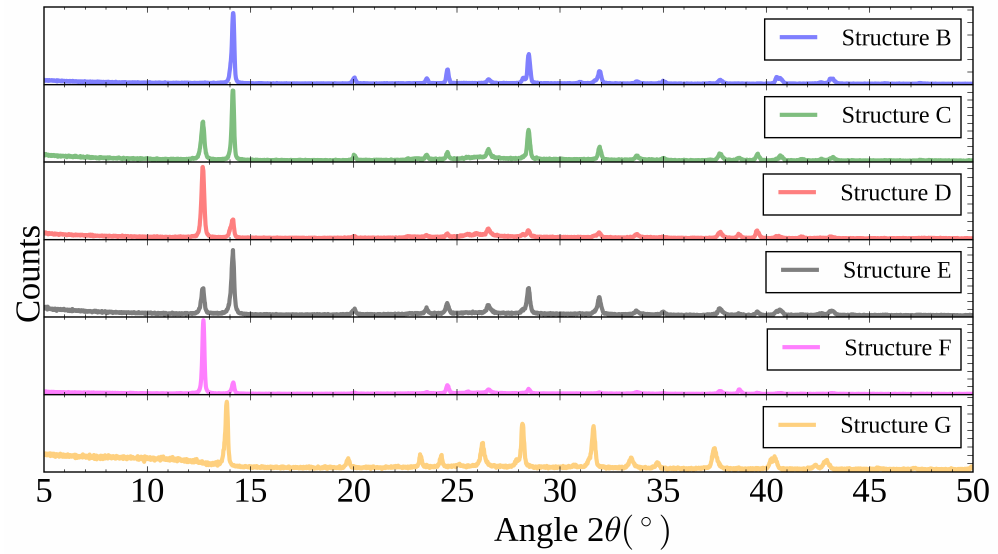
Figure 7. XRD spectra of perovskite films formed from (structure B) dip coating or (structures C to G) slot-die coating of methylammonium iodide alcohol-based formulations on lead iodide